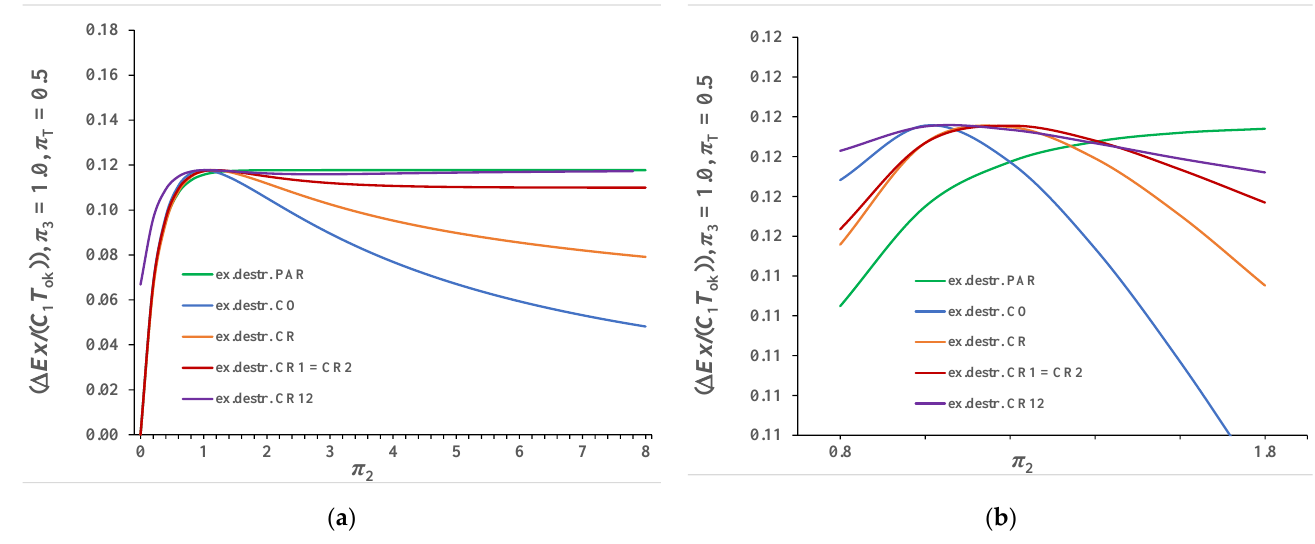
Figure 11. Dependence of exergy destruction on π 2 for π T = 0.5 and π 3 = 1.0: ( a ) 0 < π 2 < 8.0; ( b ) 0.8 < π 2 < 1.8. In this case as well, each type of recuperator reaches a local extreme maximum, for which the positions of the corresponding π 2stac , together with the equal values of the max- ima, are more clearly shown in Figure 11b. In this case, according to Equation (51), ε stac = 0.50, and the corresponding values of π 2stac for counter-flow and all cross-flow recupera- tors are 1.0, 1.15, 1.18, 1.18 and 1.23. The maximum value of exergy destruction, according to Equation (56), is 0.1178.